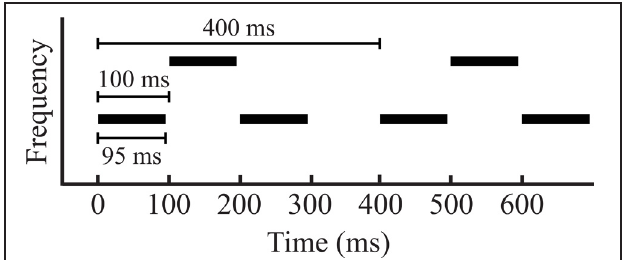
FIGURE 1 | A diagram of stimulus parameters that shows two triplets. The length between each triplet was 400ms, with 100ms stimulus onset asynchrony (SOA) between each tone, and a tone length of 95ms. In the two conditions, the middle tone of the triplet was separated from the first and third by either 1.5 or 3